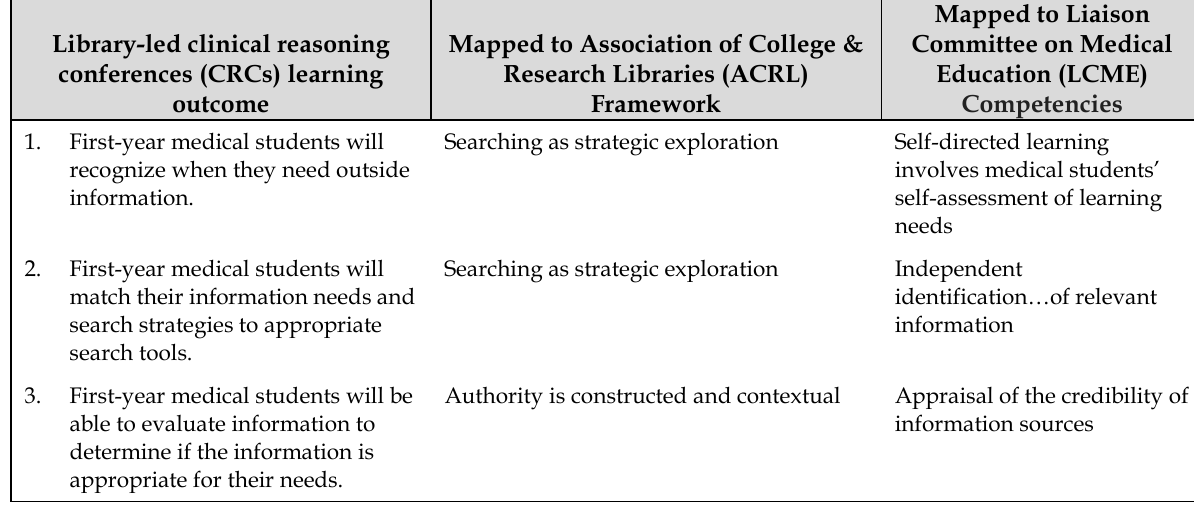
Table 2 Videos mapped to learning outcomes*